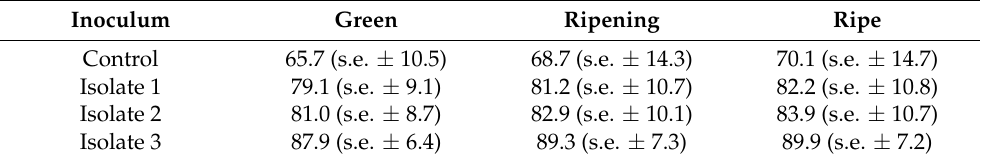
Table 3. The overall incidence (% fruit with Cladosporium present) of Cladosporium on stigmata across raspberry developmental stages and between inoculums. s.e.: standard error of the means. Inoculum